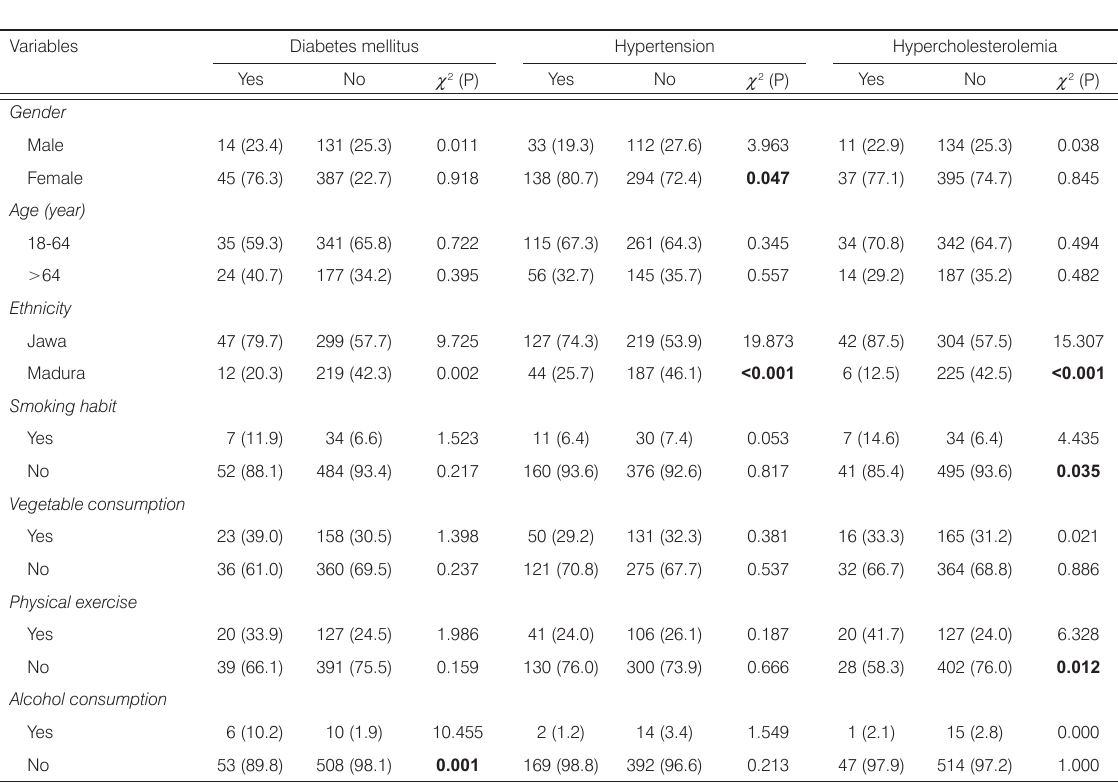
Table 1. Characteristics of participants correlatation with diabetes mellitus, hypertension, and hypercholesterolemia among patients who visit Posbindu-NCD ( n = 577).